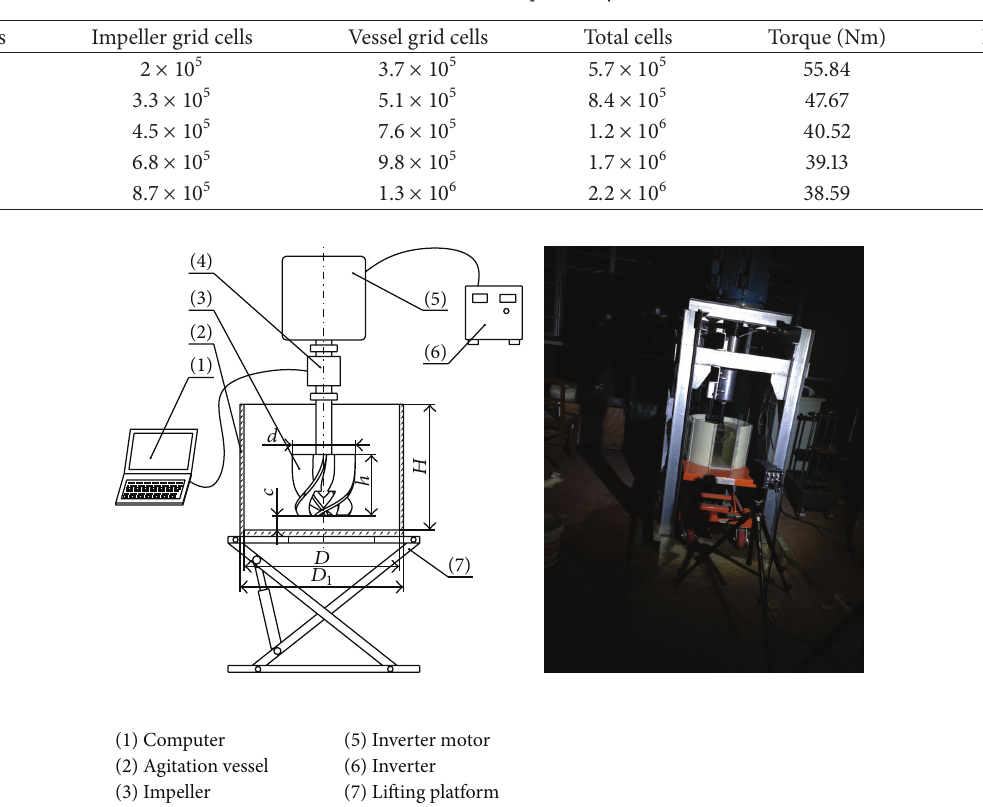
Table 2: Grid independency.